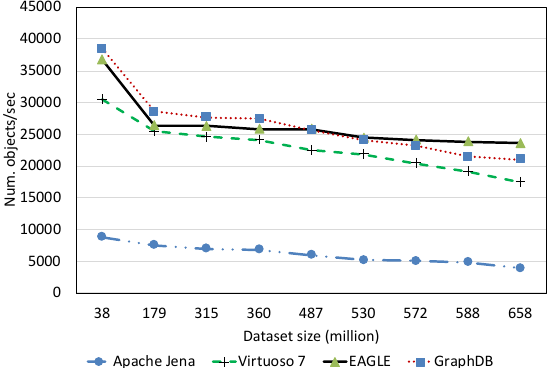
Figure 13. Average spatial data loading throughput.